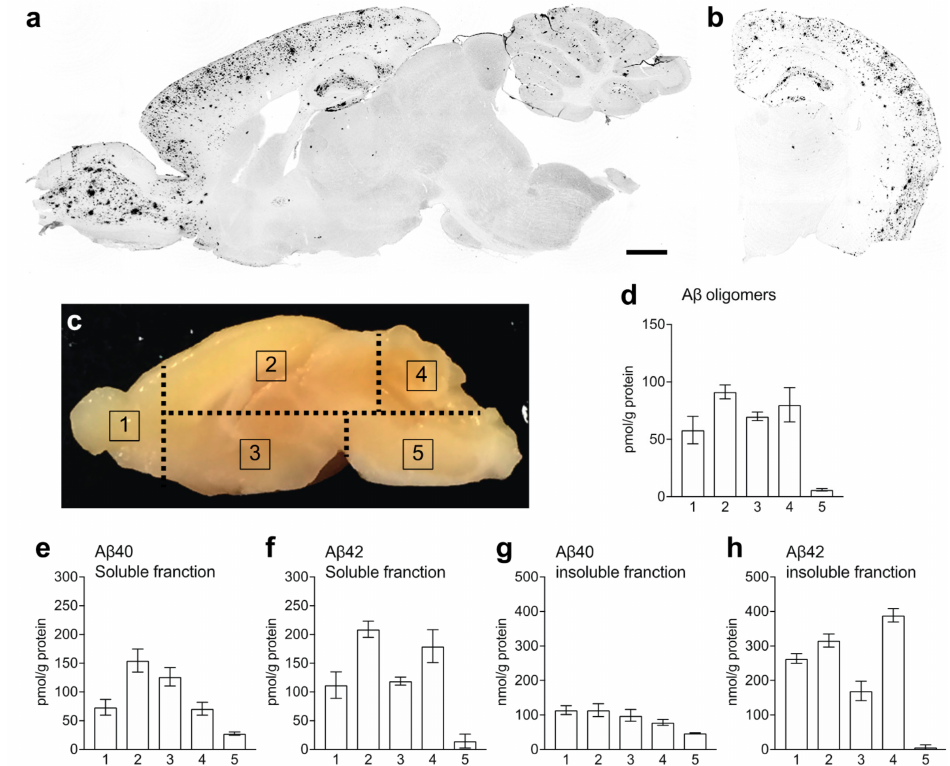
Figure 5. The levels of amyloid β (A β ) in APP/PS1 mice. ( a,b ) Representative photographs showing immunohistochemistry for A β in the sagittal ( a ) and coronal ( b ) sections of APP/PS1 mouse brain. ( c – h ) The brains were cut into five pieces according to the dashed lines in ( c ), and the levels of A β oligomers ( d ) in the soluble fraction and A β 40 ( e , g ) and A β 42 ( f , h ) in the soluble ( e , f ) and insoluble ( g , h ) fractions were measured in each region. Data are presented as mean ± SEM. Scale bar: 1